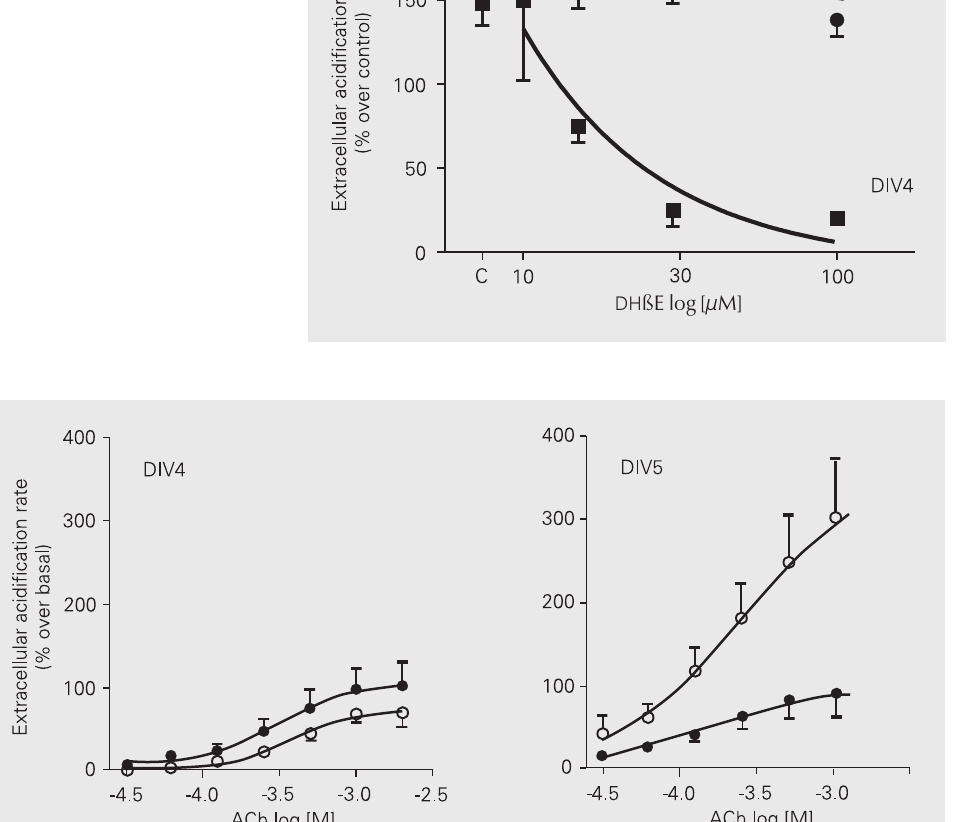
experiments.Figure 2. Acetylcholine-induced increase in extracellular acidifi- cation rate of retinal cells iso- lated from 8-day-old embryos and cultured for 4 (DIV4, tri- angles), 5 (DIV5, circles) and 6 (DIV6, squares) days in vitro . Cells (4 x 10 6 ) were exposed to increasing concentrations of acetylcholine for 10 s. The inter- val between subsequent con- centrations was 40 min in order to avoid desensitization, and only one concentration-re- sponse curve was obtained for each well. Data are reported as means ± SEM for 5-13 inde- pendent cultures. The curves were fitted according to a sig- moid concentration-response curve.....